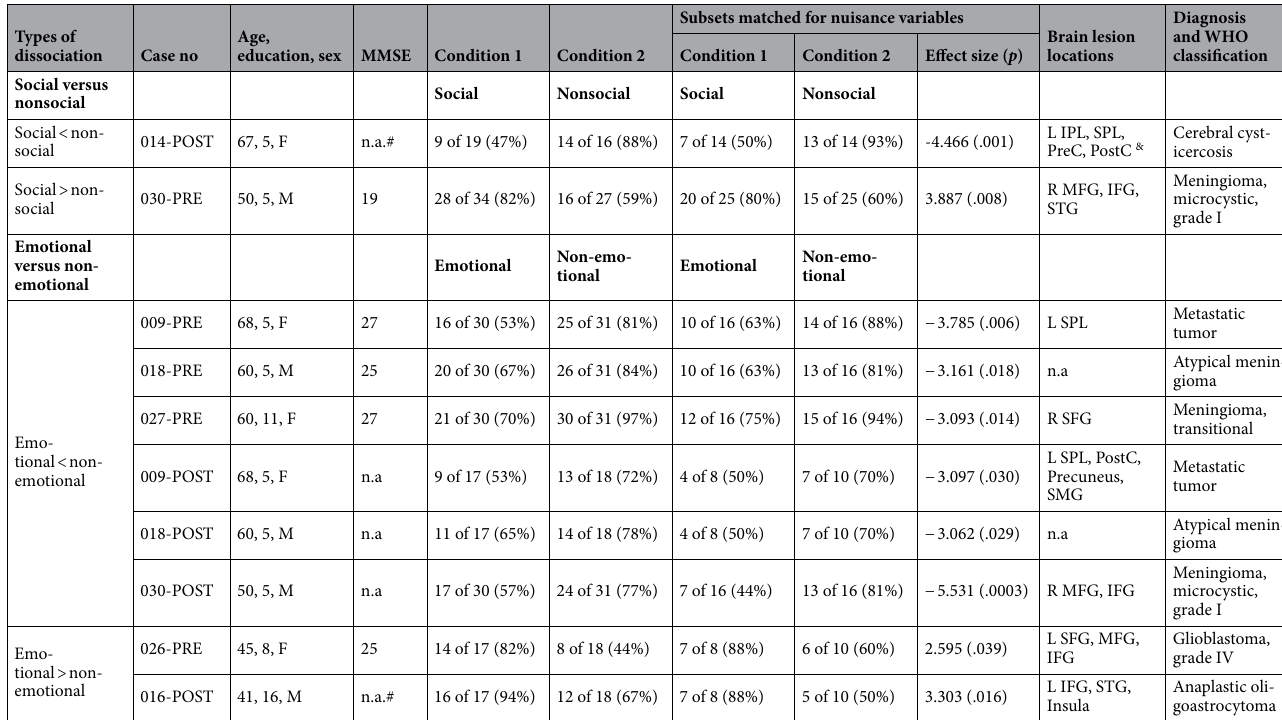
Table 2. Semantic performance (proportion correct) in the original set and subsets of stimuli matching for psycholinguistic nuisance variables in patients showing FDR-corrected significant dissociations. n.a. not available, L left, R right, IPL inferior parietal lobule, SPL superior parietal lobule, PreC precentral gyrus, PostC postcentral gyrus, MFG middle frontal gyrus, IFG inferior frontal gyrus, STG superior temporal gyrus, SFG superior frontal gyrus, SMG supramarginal gyrus, F female, M male. # : 014-POST, presurgical MMSE score = 19; 016-POST, presurgical MMSE score = 28; &, lesion locations in the case’s presurgical MRI scan are shown because her postsurgical MRI scan is not